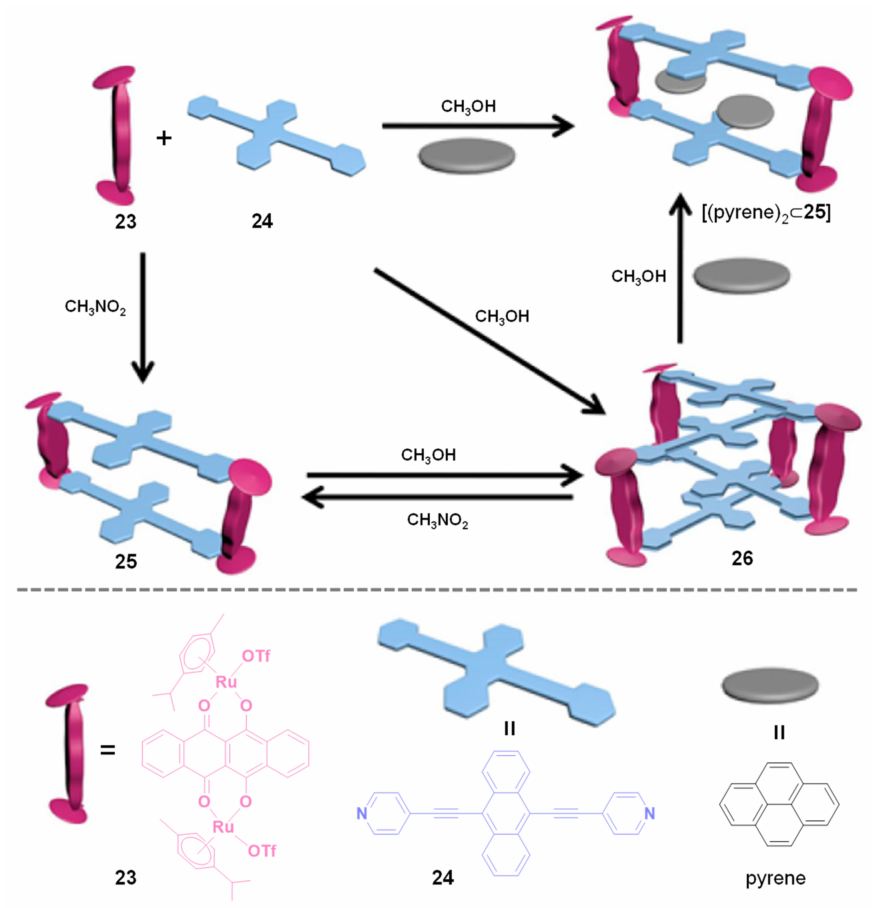
Figure 5. The reversibly fine-tuned self-assembly among monorectangle and catenane structures. Reprinted with permission from Ref. [70]. Copyright 2015 American Chemical